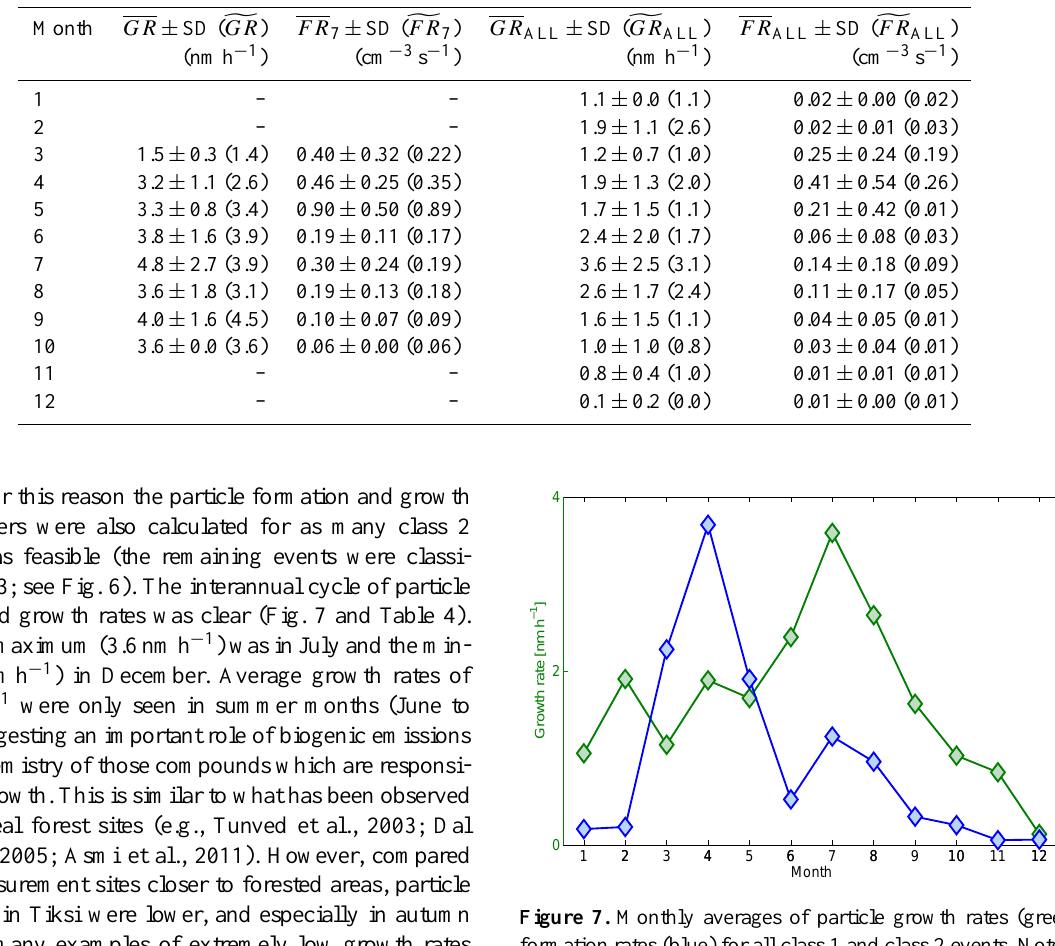
Table 4. Secondary particle growth rates and formation rates in different months. First column indicates the month. The second column (GR) and the third column (FR 7 ) show the particle growth rate and formation rate parameters calculated for class1 events only. The fourth column (GR ALL ) and fifth column (FR ALL ) present the growth rate and formation rate parameters calculated for all the events (class 2 included). Values in each column present the monthly averages with standard deviations followed by the medians in parenthesis.